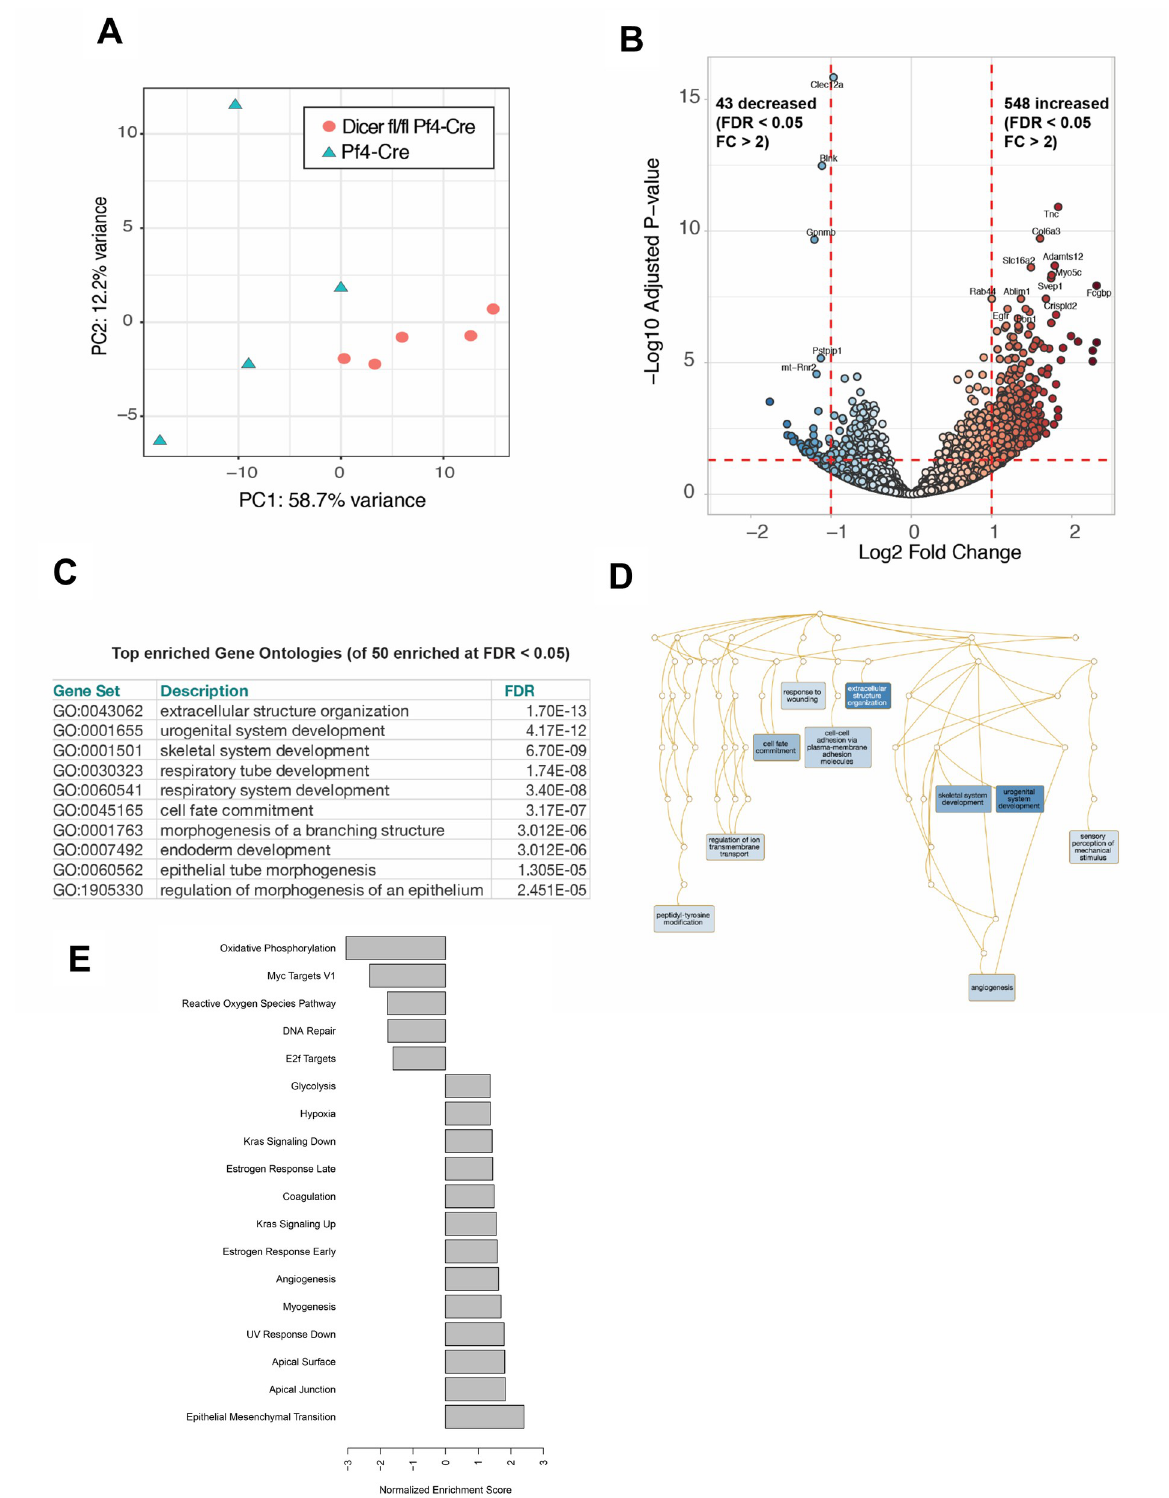
Fig 3. Modulation of tumor cell mRNA expression by platelet miRNAs in ectopic primary solid tumors in vivo . Tumors were resected, disrupted into single cell suspensions, the suspensions were labeled with Epcam antibodies, and tumor cells were single cell sorted for high Epcam-expressors as detailed in Methods (four control mice and five Dicer1 fl/fl / Pf4 -Cre mice). RNA was extracted and analyzed by RNA-seq for